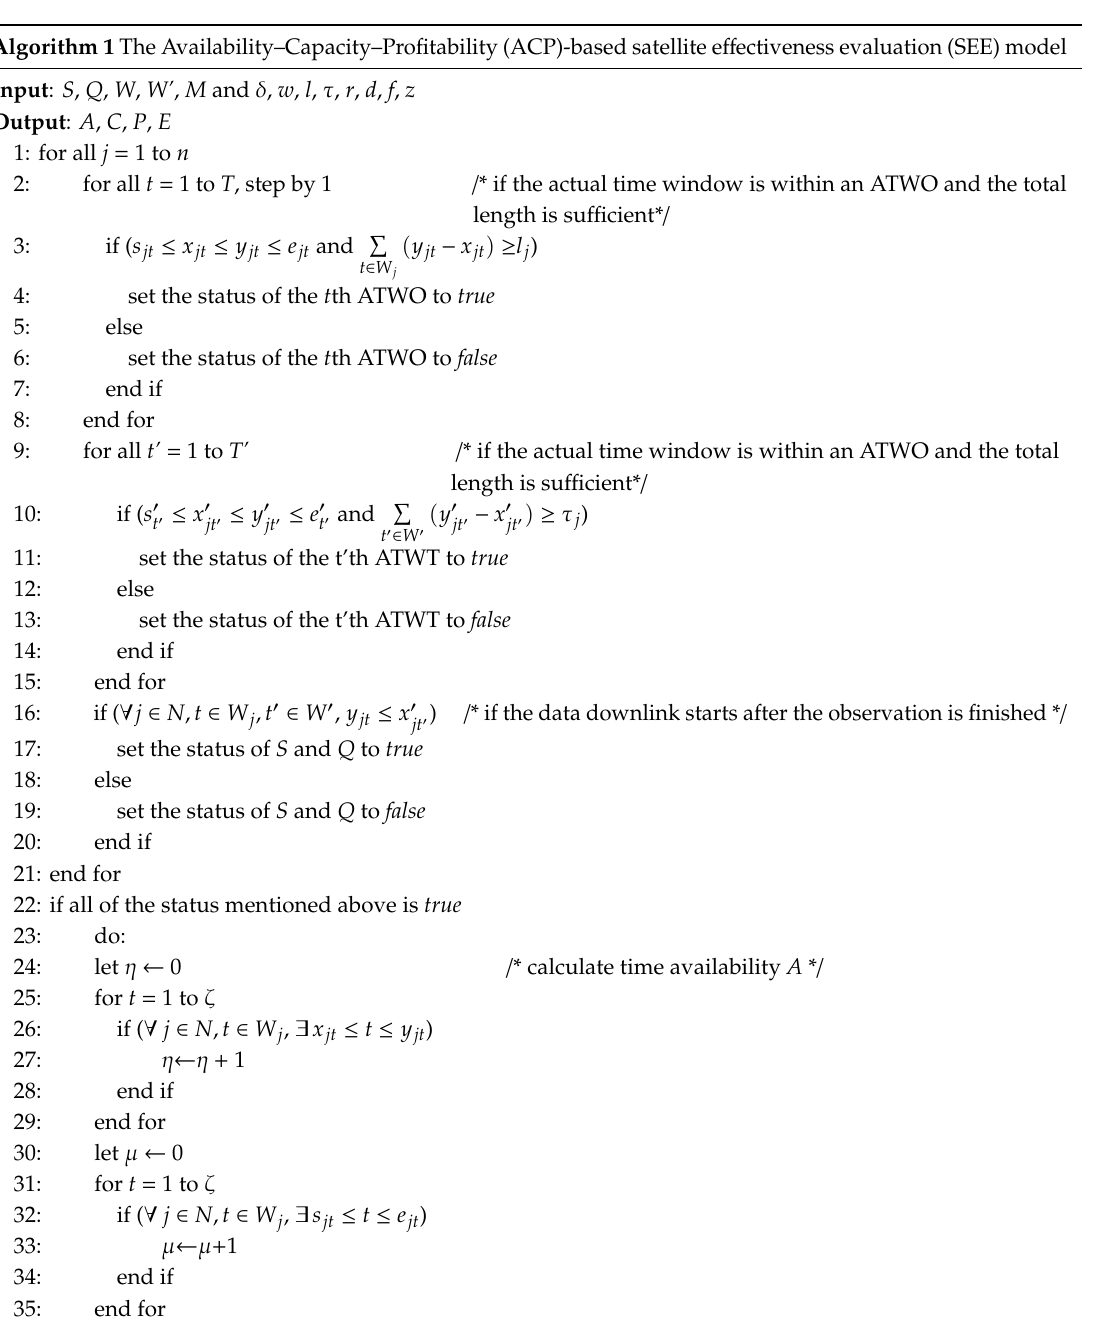
Algorithm 1 The Availability–Capacity–Profitability (ACP)-based satellite e ff ectiveness evaluation (SEE)